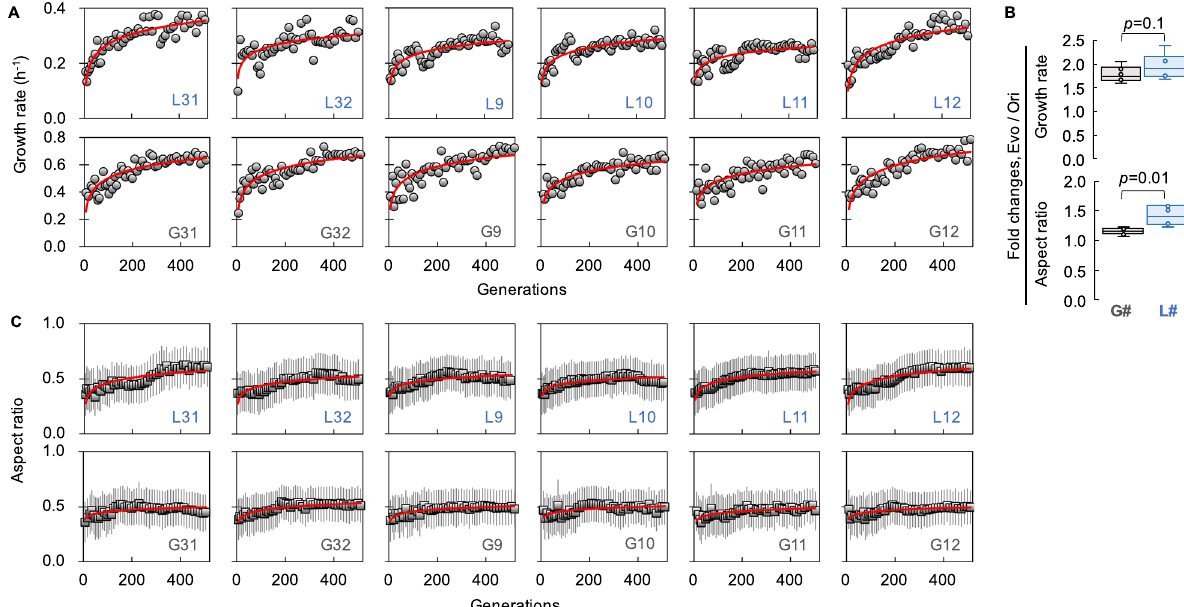
Fig. 1 Evolutionary changes in the growth rate and morphology of E. coli . A Changes in the growth rate. One out of three cultures of varied dilutions were selected for the following serial transfer. The growth rate of the selected culture was used to assess temporal changes. Logarithmic regression of the temporal changes is represented by the red solid curve. B Fold changes in growth and cell shape mediated by experimental evolution. The upper and bottom panels represent the fold changes in growth rate and aspect ratio, respectively. The fold changes were calculated as the ratios between the endpoint populations (L# and G#) and the Ori. Box plots indicate the distributions of the fold changes, in which the six lineages are indicated with open circles. The statistical signi fi cance is indicated with the p values. C Changes in the cell shape. The cell shape, i.e., the aspect ratio, of the transferred cell populations is shown with respect to those in ( A ). The means and standard deviations were calculated from 10,000 cells subjected to imaging fl ow cytometry, and they are represented with horizontal and vertical black lines, respectively. Logarithmic regression of the temporal changes is represented by the red solid curve. The labels of the six lineages evolved in OAVs (L#) and glucose (G#) are